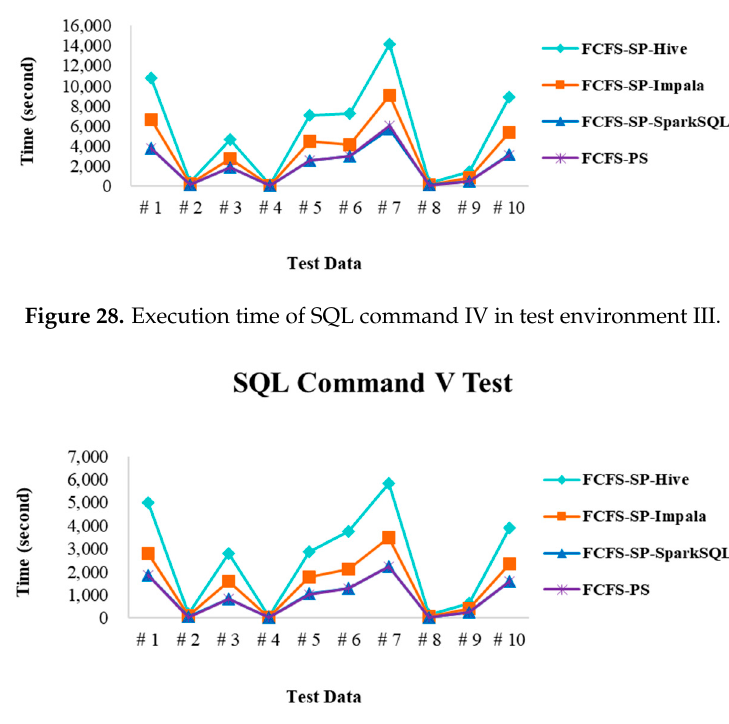
Figure 29. Execution time of SQL command V in test environment III.